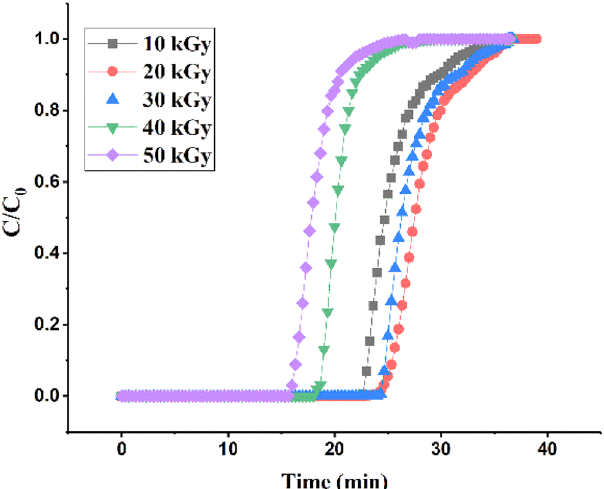
Figure 9. Breakthrough curves of CO 2 adsorption.